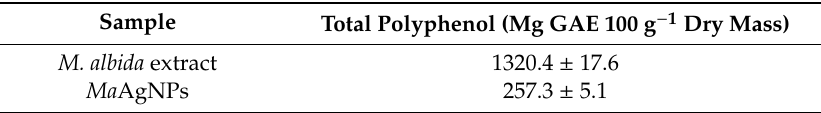
Table 2. Total olyphenol content in M. albida and Ma